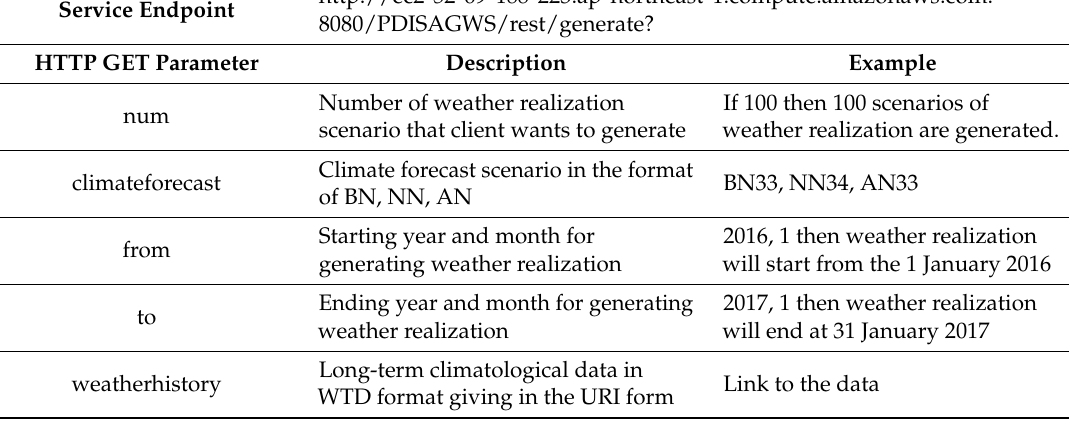
Table 4. Request parameter of the predictWTD